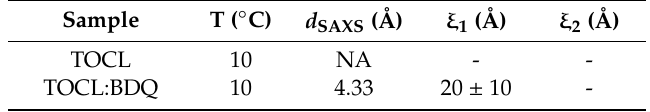
Table 8. WAXS di ff raction patterns of TOCL and TOCL with BDQ at 5% molar ratio at 10 and 37 ◦ C.